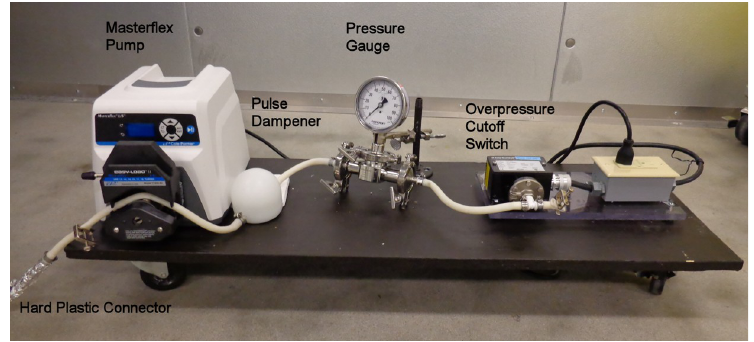
Fig 5. Pump assembly includes an Easy Load Masterflex pump, pulse dampener, pressure gauge, and overpressure cutoff